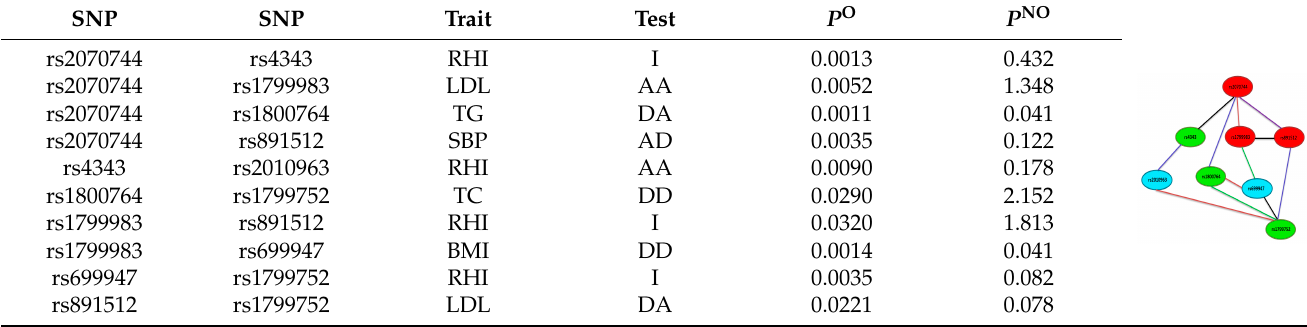
Table 6. Significant SNP-SNP cross talks amongst eNOS, ACE and VEGFA genes and their association with traits. SNP SNP Trait Test P O P NO